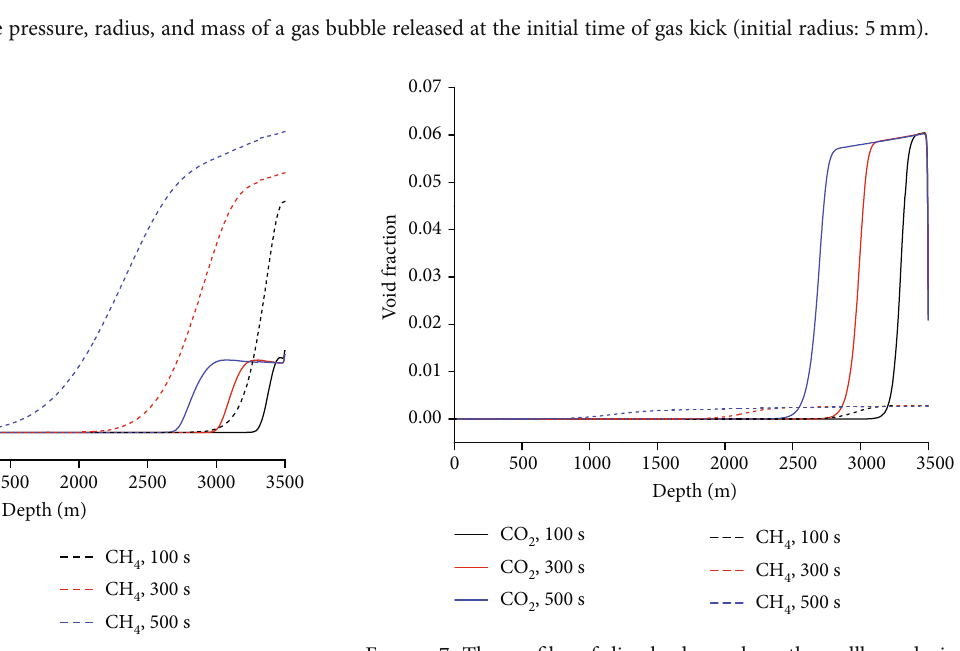
Figure 6: The pro fi les of free gas along the wellbore during methane and CO kicks. 2